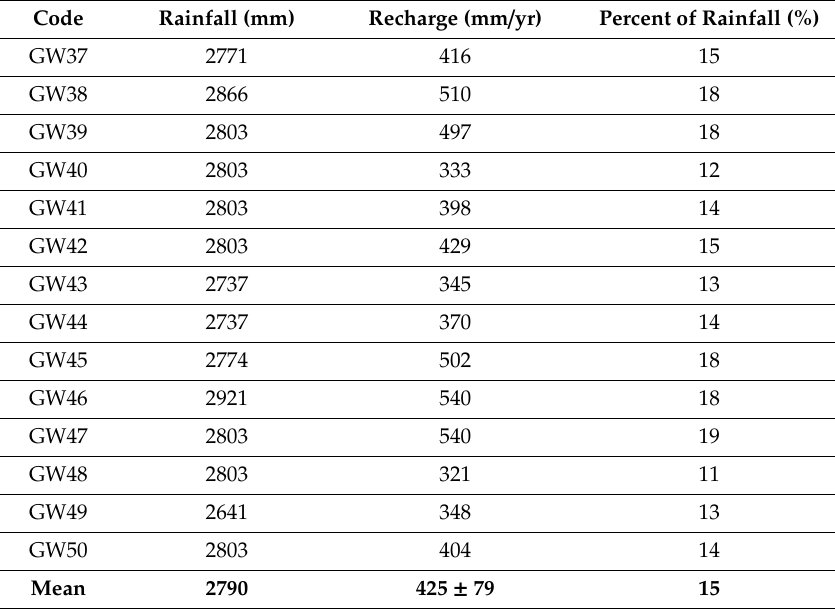
Table 3. Summary of estimated groundwater recharge (mm / yr and